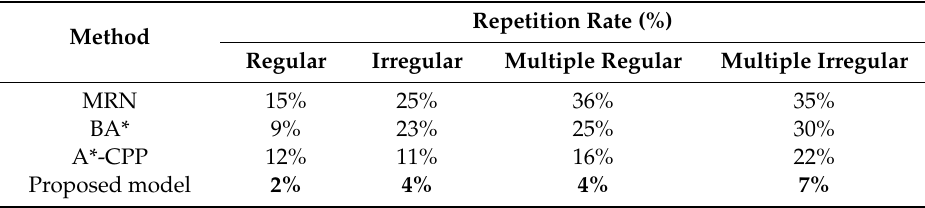
Table 6. A comparative analysis of the repetition rate in traversing the operational